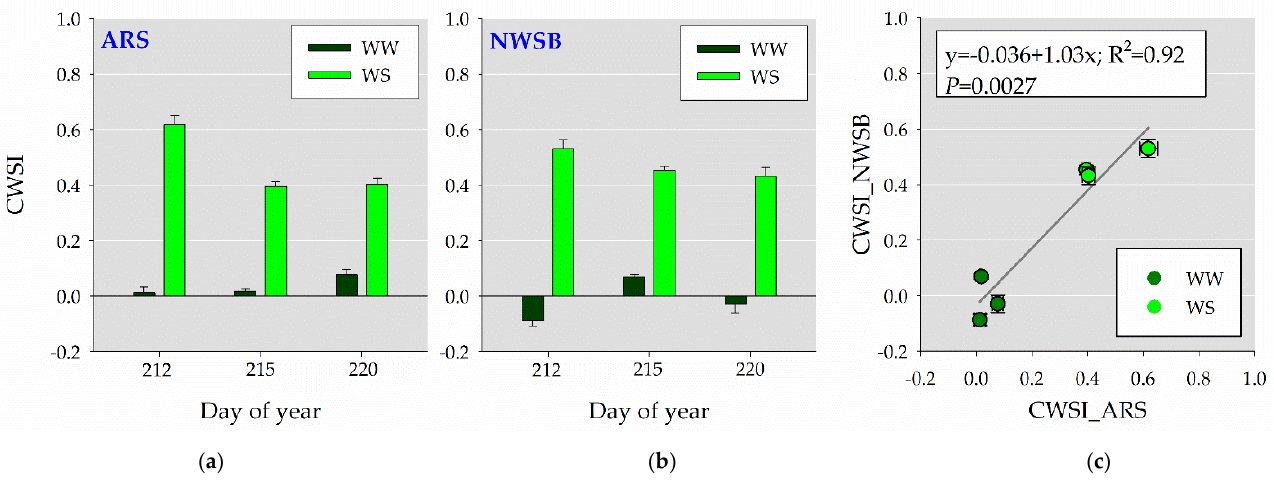
Figure 11. ( a ) ARS-based crop water stress index (CWSI) for WW and WS treatments, ( b ) NWSB-based CWSI for WW and WS treatments, and ( c ) the relationship between ARS-based and NWSB-based CWSI. The data comes from the 2018 growth cycle. In ( a – c ), the error bars represent the standard error of the mean (n = 18).